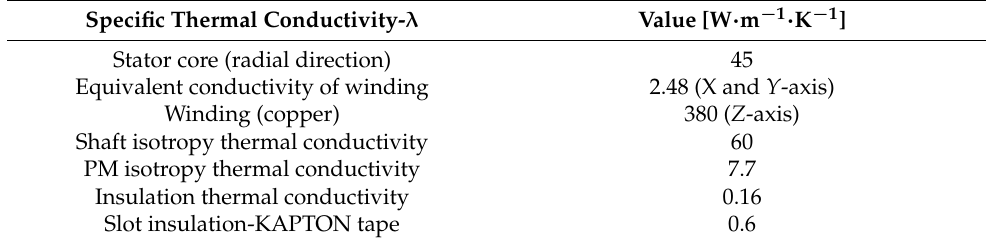
Table 1. Used parameters for simulation setup.